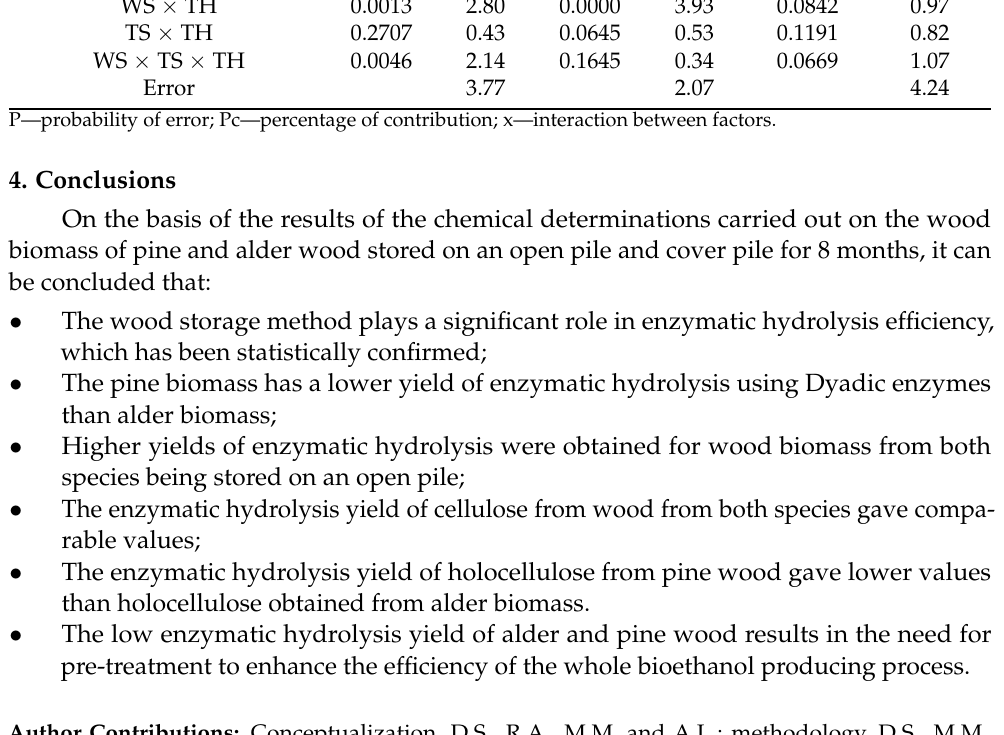
Hydrolysis of Wood Holocelulose Celullose